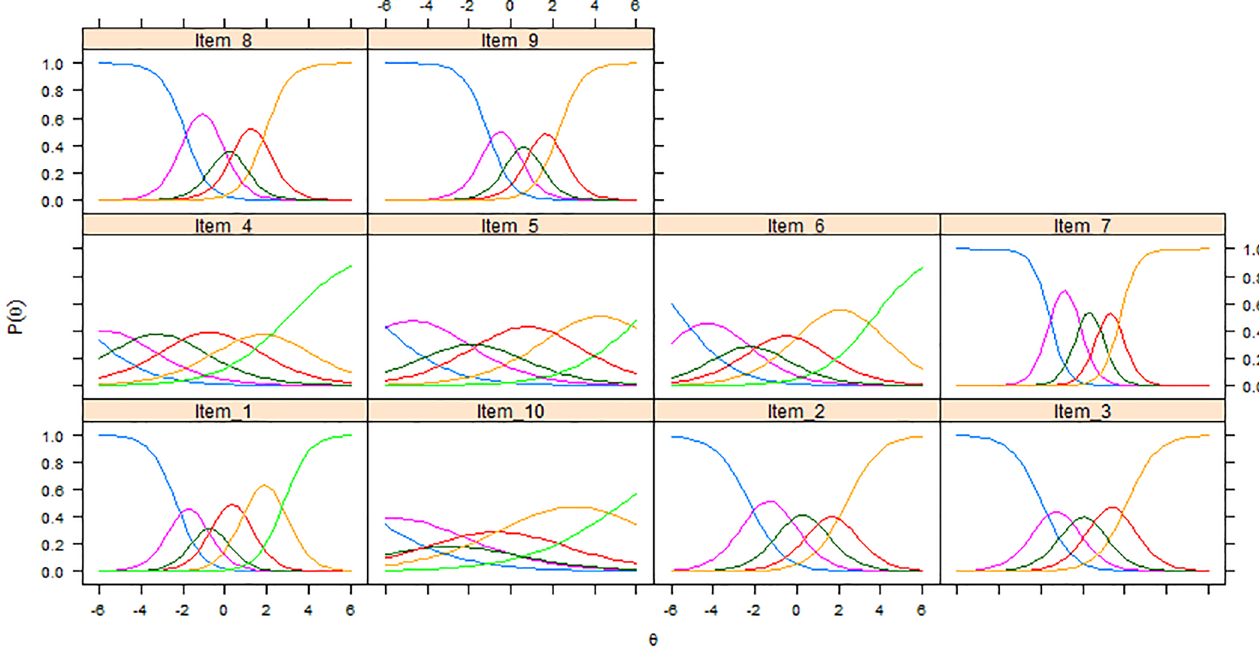
Fig 3. Item characteristic curves of the 10 items of the biomedical scale of the Pain Attitudes and Beliefs Scale (PABS) in the DABS study.